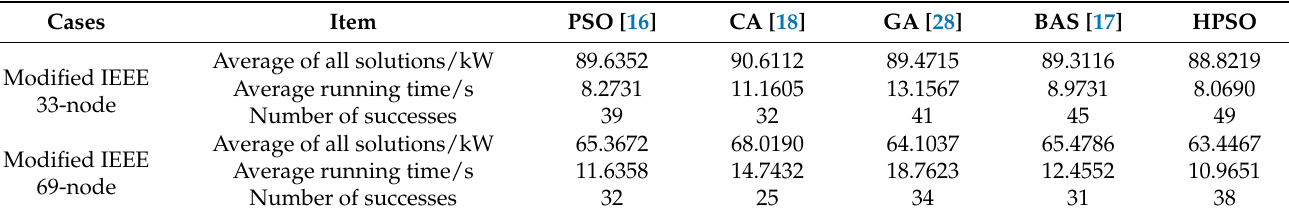
Table 2. Results of different metaheuristic algorithms.